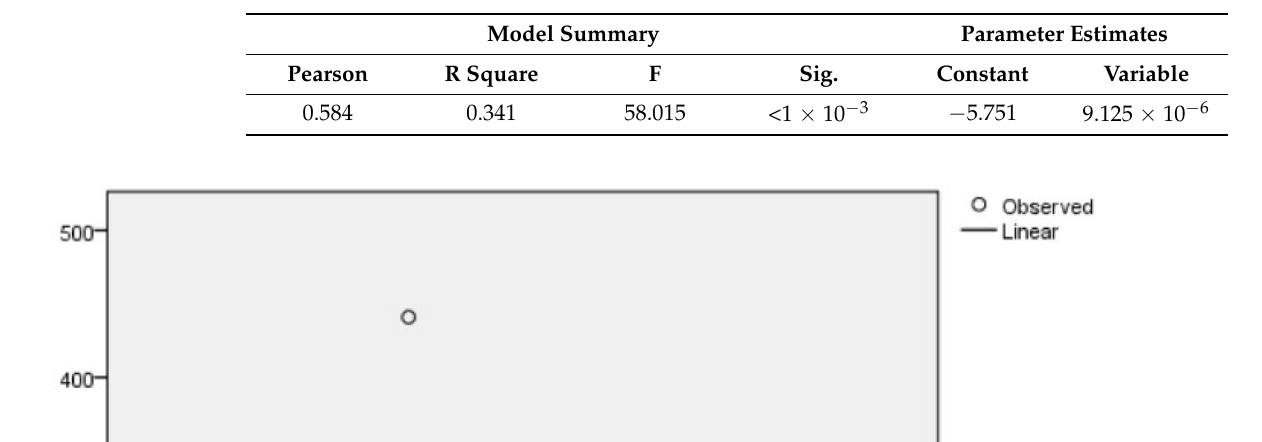
Table 7. Correlation between amount funding and number of publications.